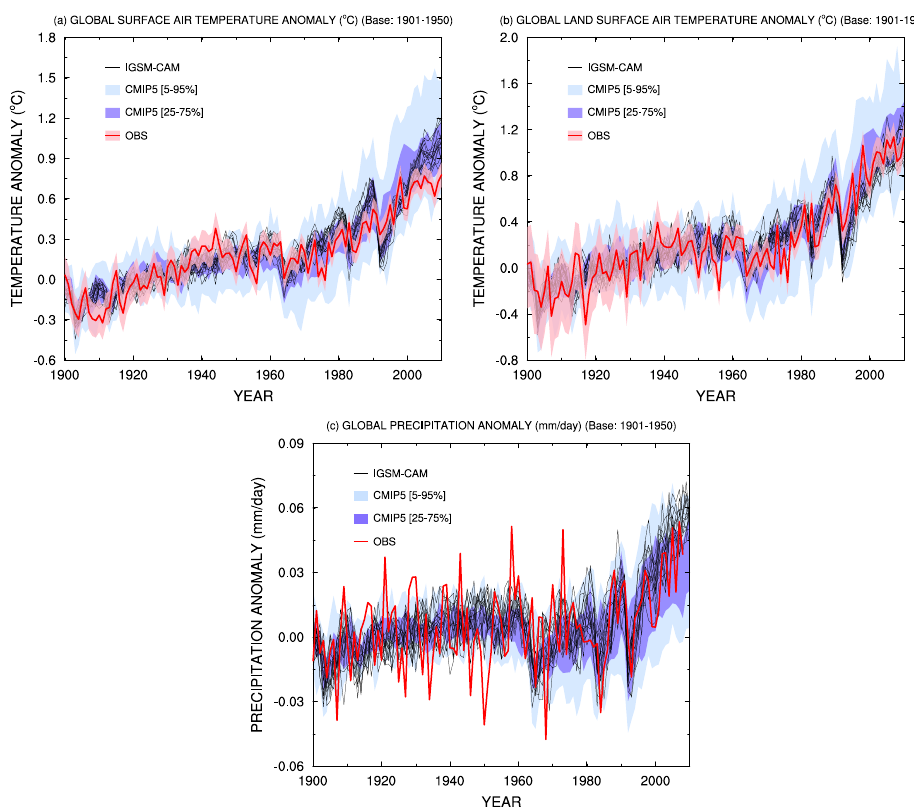
Fig. 12. Global mean (a) land-ocean surface air temperature anomalies ( ◦ C), (b) land-only surface air temperature anomalies and (c) precipi- tation anomalies (mmday − 1 ) from the 1901–1950 mean for the IGSM-CAM simulations, observations and CMIP5 models. The IGSM-CAM simulations are represented by black solid lines. The observations are shown in red lines, with the uncertainty shown in a pink band when available. The 5–95% (25–75%) range of the CMIP5 simulations are shown in light (dark) blue. For the land-ocean surface air temperature, HadCRUT4 is shown for observations. For land-only surface air temperature, CRUTEM4 is shown. For precipitation, REC is shown.